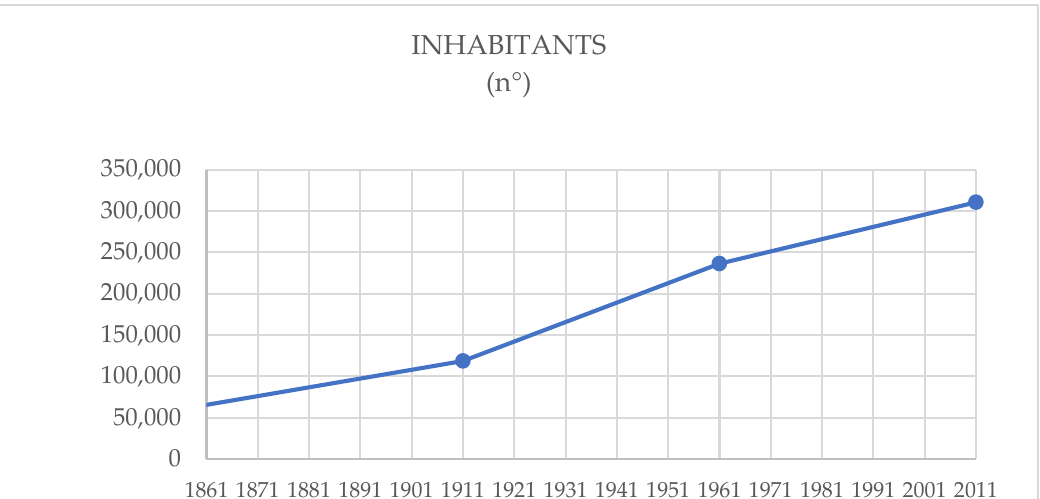
Figure 2. The study area based on a 2005 Regional Topographic Map.